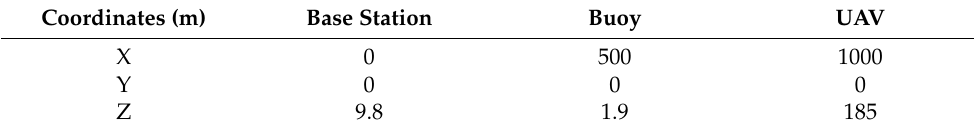
Table 3. Positions of different nodes of the simulations regarding base station.